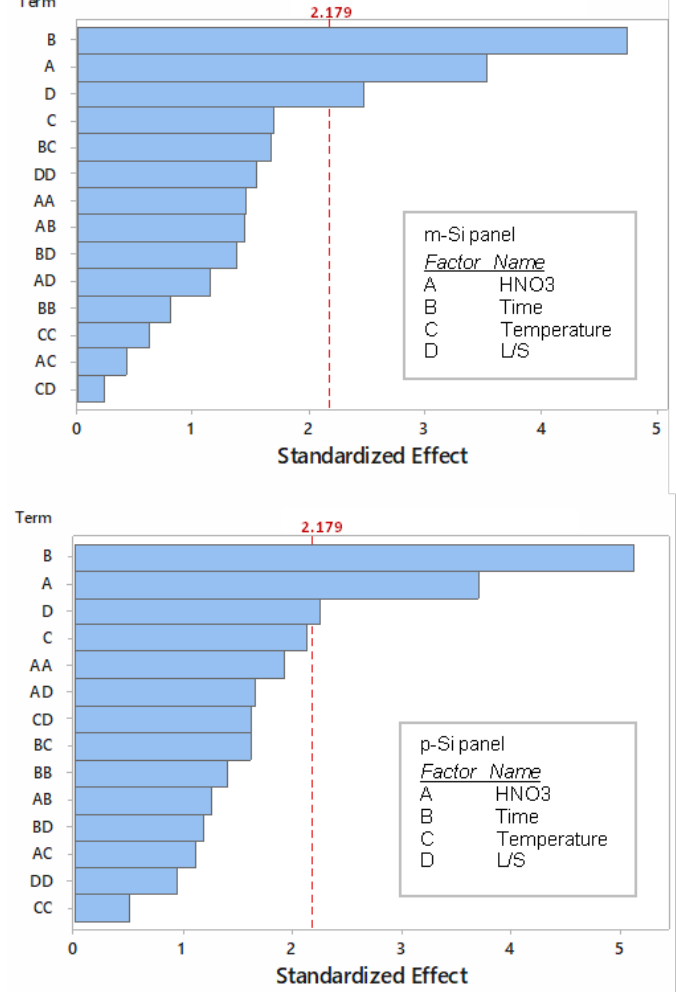
Figure 3. Pareto chart of standardized effects of the factors and interactions for Ag leaching from m-Si and p-Si panels.